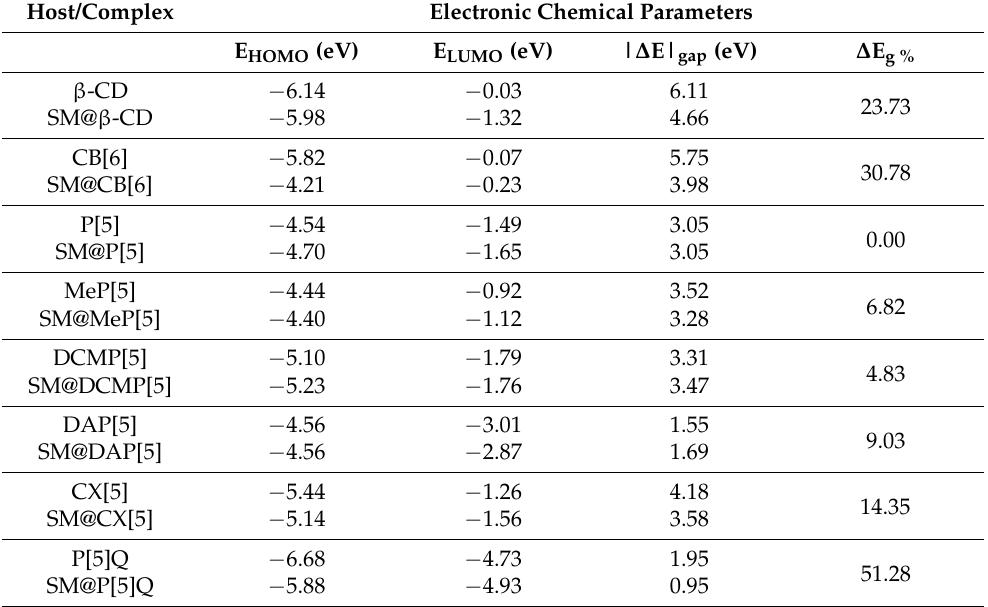
Table 5. Calculated HOMO, LUMO, HOMO-LUMO energy gap and the percentage of variation of HOMO–LUMO gap of studied complexes with r 2 SCAN-3c in gas phase. Host/Complex Electronic Chemical